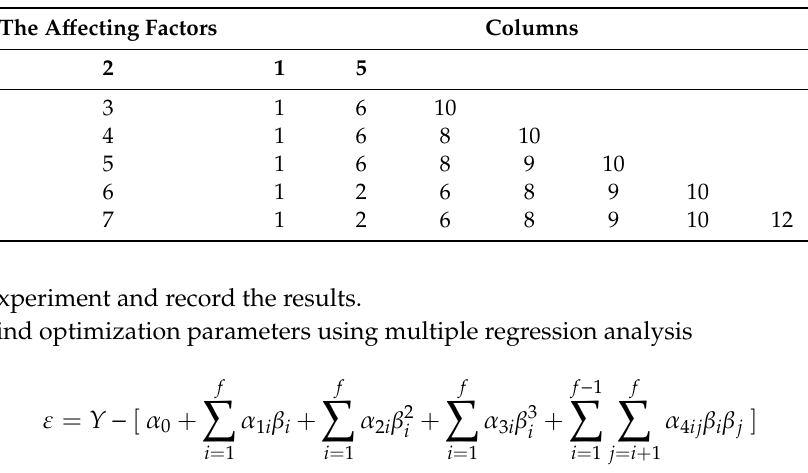
Table 2. If the a ff ecting factor is 6, select the 1, 2, 6, 8, 9 and 10 columns. The results are shown in the grey background of Table 1. Table 2. Usage table of U 13 ( 13 12 )